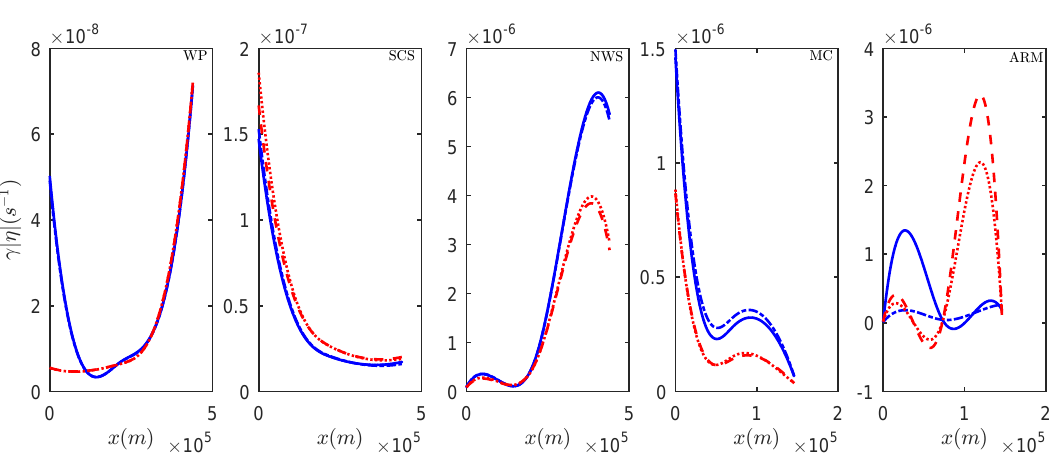
Figure A1. The frictional index γ | η | for the five cases, where | η | is set to be the initial amplitude. From left to right, they are the cases, Western Portugal, the South China Sea, the North West Shelf, the Malvinas Current and the Amazon River mouth. For each panel, it represents the frictional index in summer with the background current (blue, solid), without the current (blue, dashed-dotted) and in winter with the current (red, dash), without the current (red, dot),